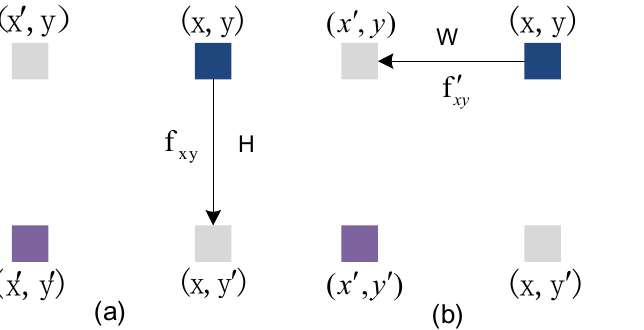
Figure 4. An example of position information propagation, ( a ) represents column-adjacent attention, ( b ) represents row-adjacent